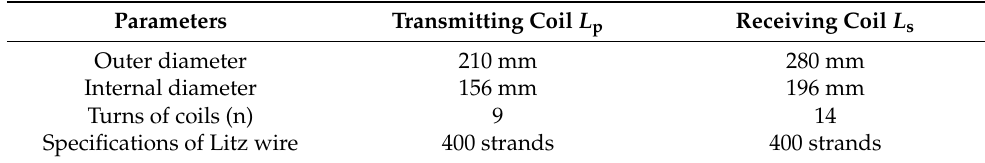
Table 1. Dimensional parameters of the designed LCT.